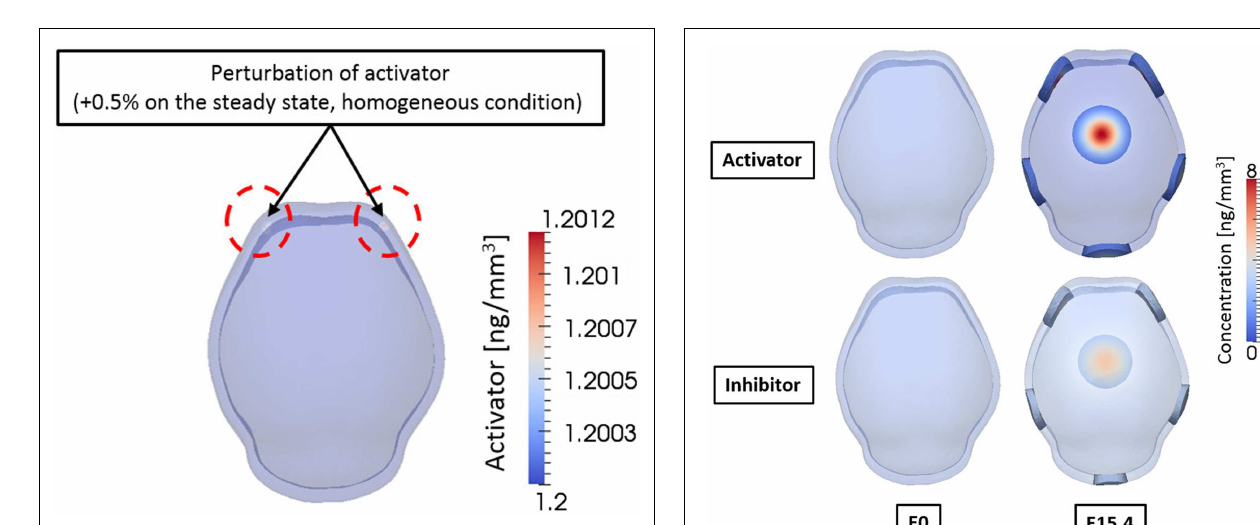
FIGURE 7 | Procedure for constructing a computational domain . (A) An isosurface of the cranial vault bones from a three-dimensional reconstruction of micro CT images acquired from a mouse at E17.5 was used for making the domain and generating a mesh. Rostral end (nose) is